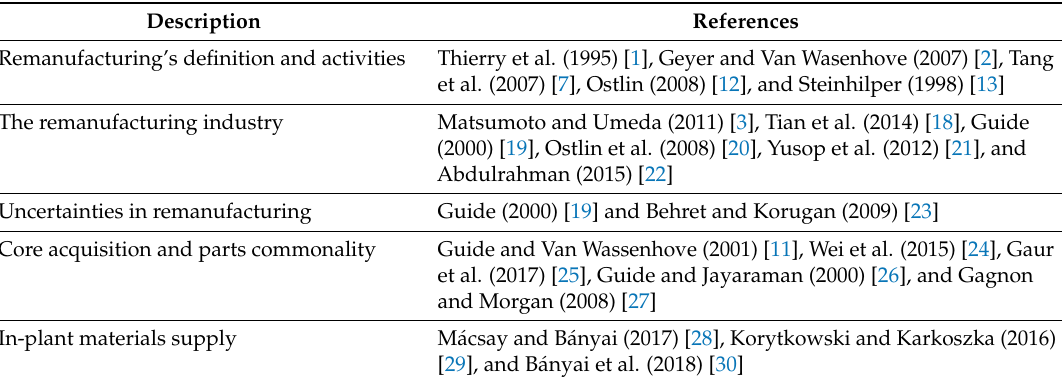
Table 1. A summary of the literature